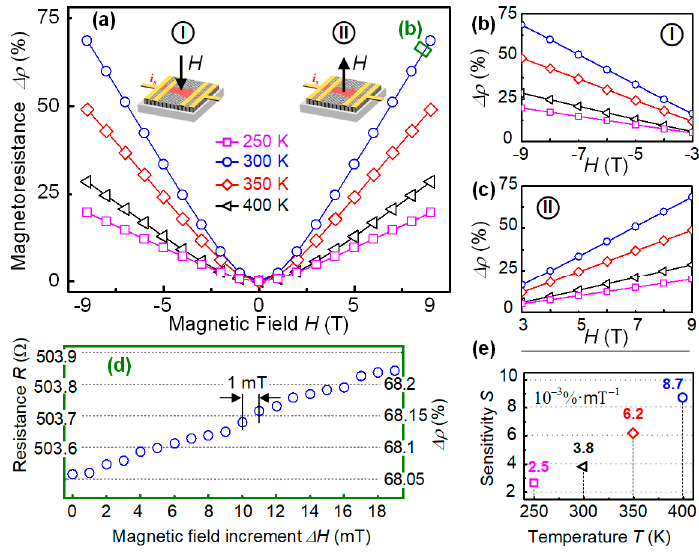
Figure 2. Magnetic sensing property of carbon film in perpendicular external magnetic field. ( a ) Temperature dependent magnetoresistance from 250–400 K. The intensity of the magnetic field was increasing from zero to 9 T along opposite directions as illustrated inside the figure; ( b ),( c ) linear magnetoresistance of the carbon film in high intensity field range |H| of 3–9 T, and the temperature dependency; ( d ) resistance and magnetoresistance in the magnetic field range of 8.946–8.966 T (indicated with green square in ( a )), with increment of 1 mT at 300 K, implying that the finest resolution can reach 1 mT; ( e ) calculated sensitivity at different temperatures from ( b ) and ( c ).